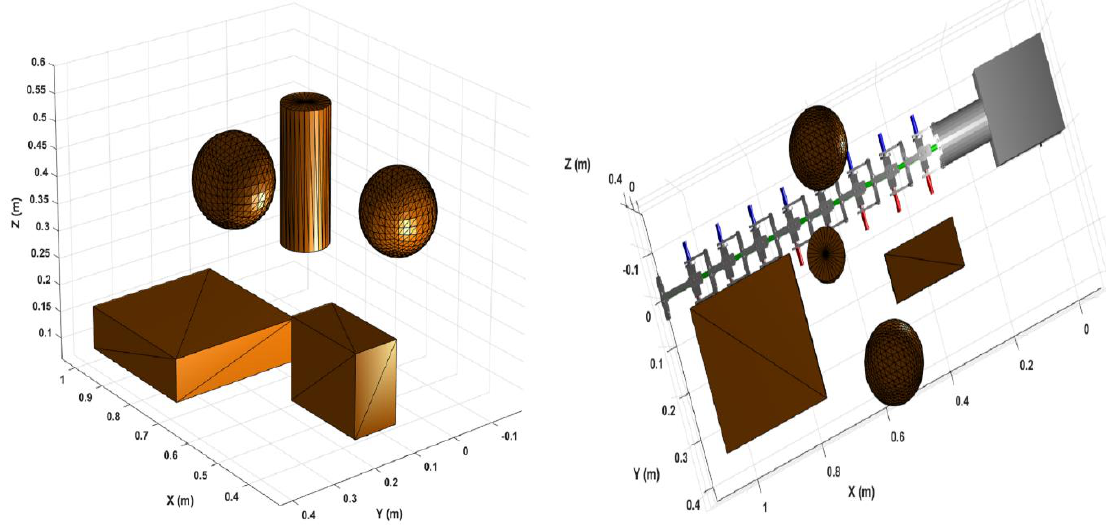
Figure 13. Enclosed semi- structured environments with the obstacles’ coordinates ( left ) and the ma- nipulator’s home configuration ( right ). manipulator’s home configuration ( right